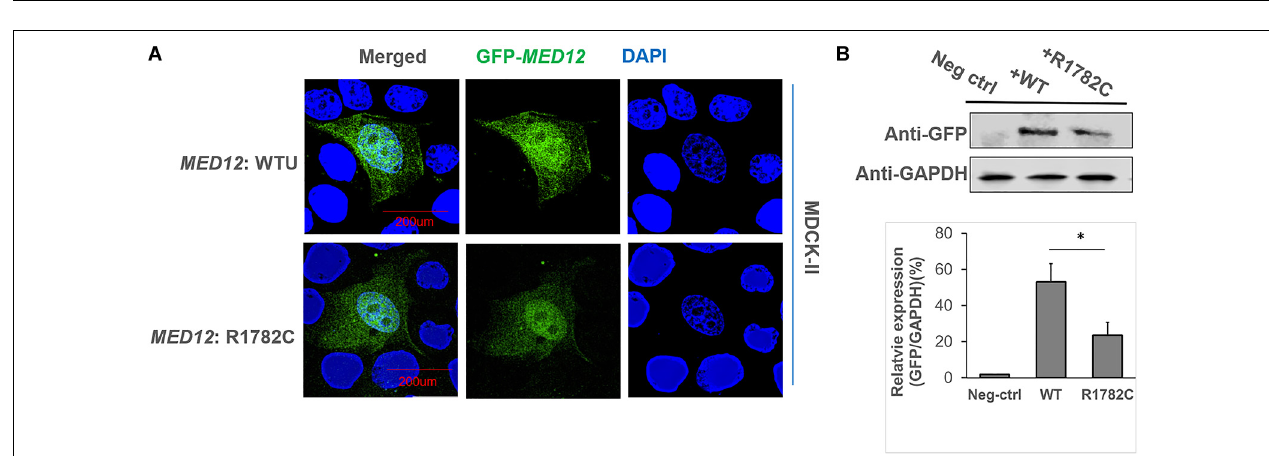
FIGURE 2 | The identified variants of MED13L in human samples. (A) Whole-exome-sequencing map and Sanger sequencing map of MED13L c.5278C > T. (B) Conserved domains and the total scheme of the target genes and positions of the identified mutations. (C) A partial alignment of human target MED13L protein with other orthologous sequences. (D) The Sanger sequencing map of PPP5C and NCKAP1L genes.